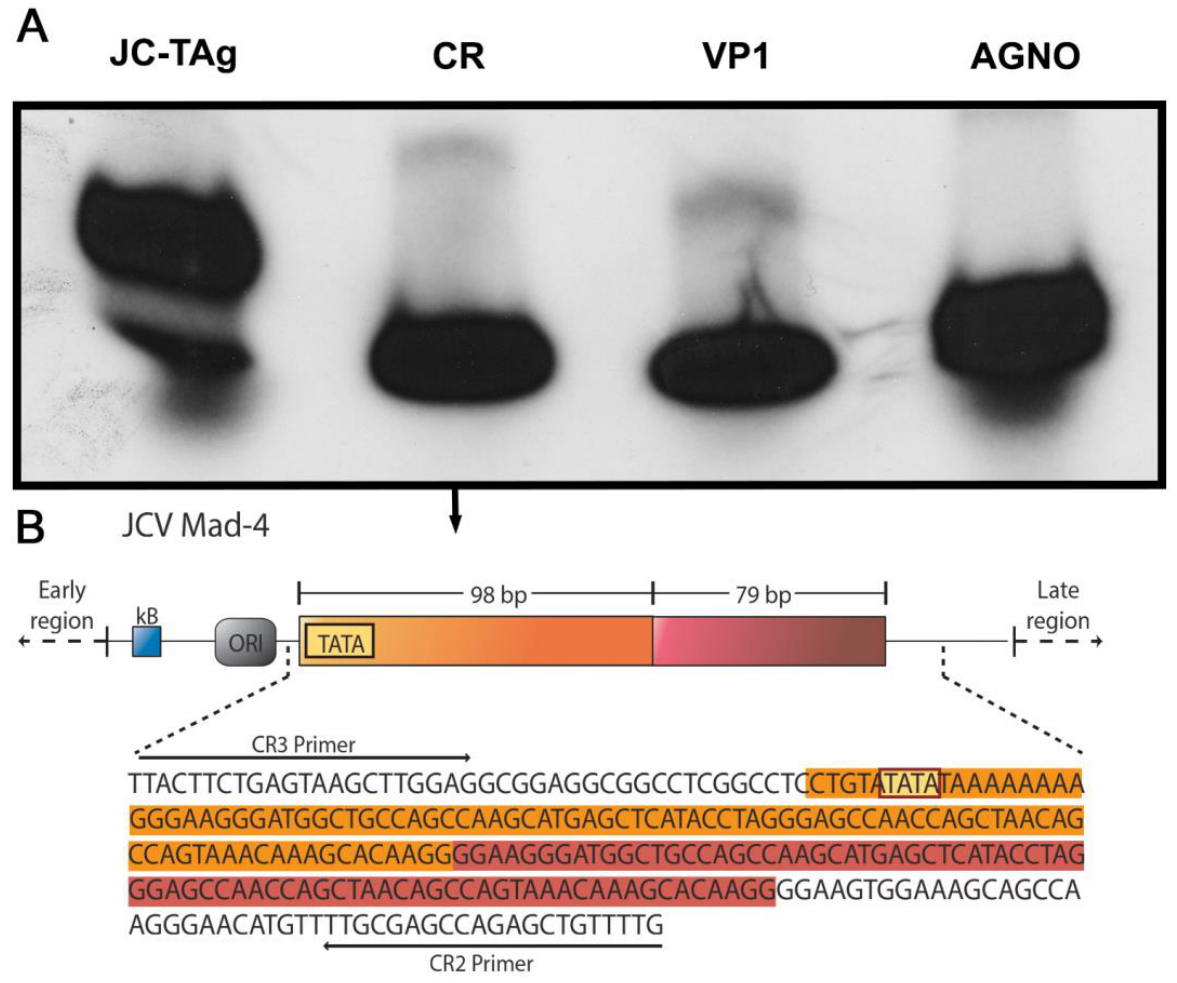
Figure 4. PCR Amplification of JCPyV genomic sequences: DNA extraction and PCR amplification from an area of tumor cells showed the presence of genomic sequences from all regions of JCPyV (Southern blot, Panel ( A )). Furthermore, sequencing of the control region amplified sequence revealed that the strain present was Mad-4. A schematic representation of the CR is shown along with the sequence and location of the primers used Panel ( B )).